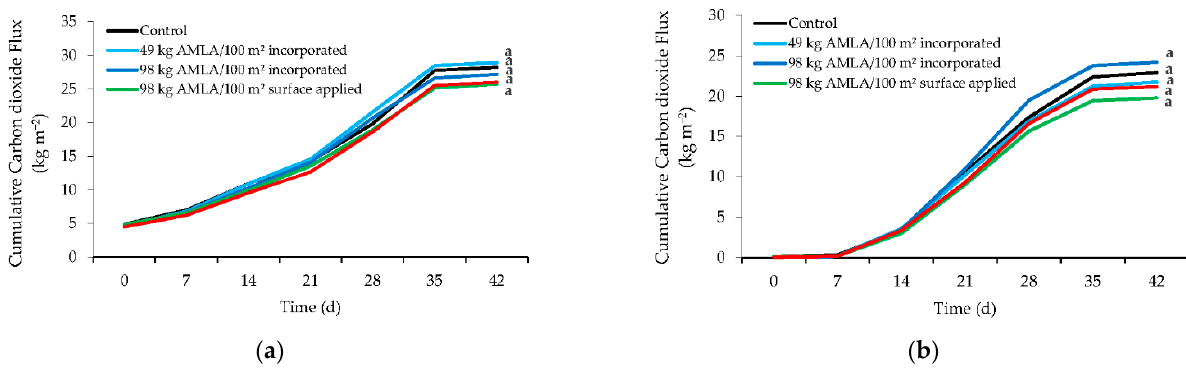
Figure 4. Cumulative carbon dioxide flux (kg CO 2 m − 2 ) for ( a ) flock 2 and ( b ) flock 3 as a function of time. Treatments on day 42 not sharing a common letter are significantly different ( p < 0.05).